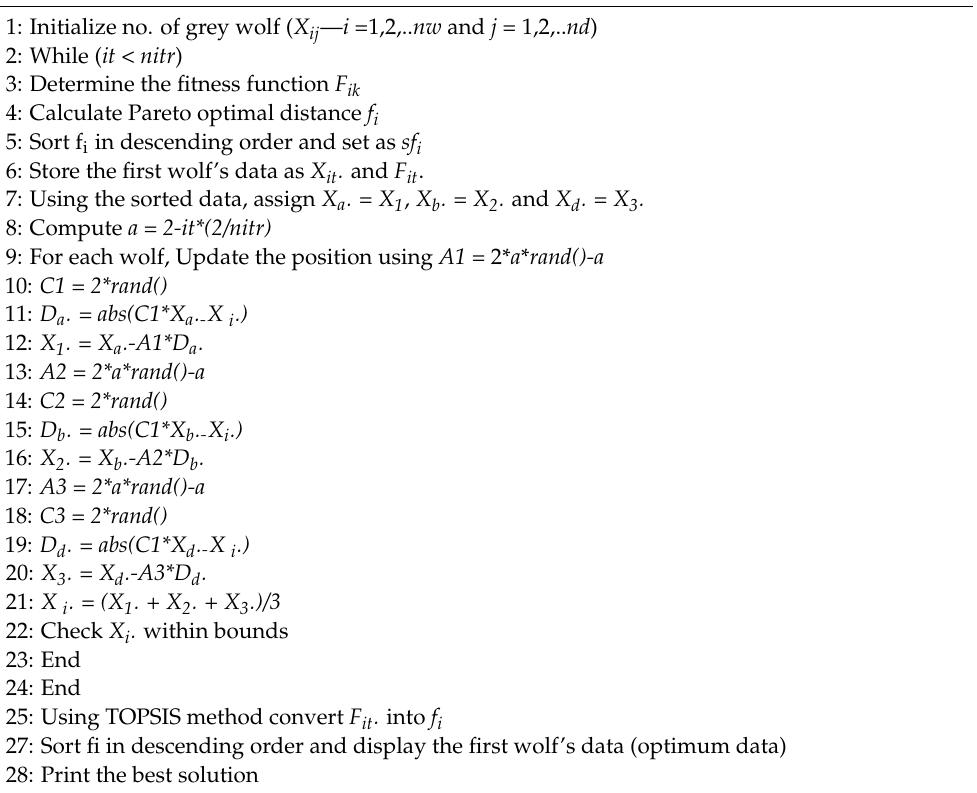
Algorithm 2 Grey Wolf Optimization Algorithm